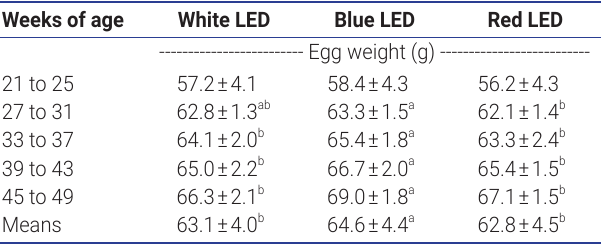
Table 8. The egg weight of Brown Tsaiya ducks in different treat- ment groups Weeks of age White LED